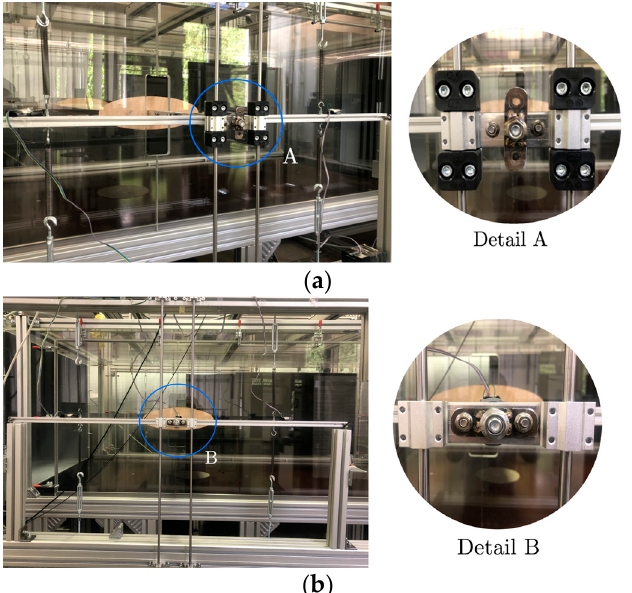
Figure 10. Single-degree-of-freedom assembly: ( a ) torsional DOF assembly; ( b ) vertical DOF assembly.